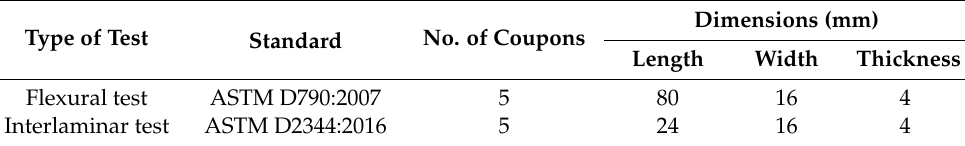
Table 2. Test specimen geometry and a number of coupons based on ASTM standard for evaluating mechanical properties. Type of Test Standard No. of